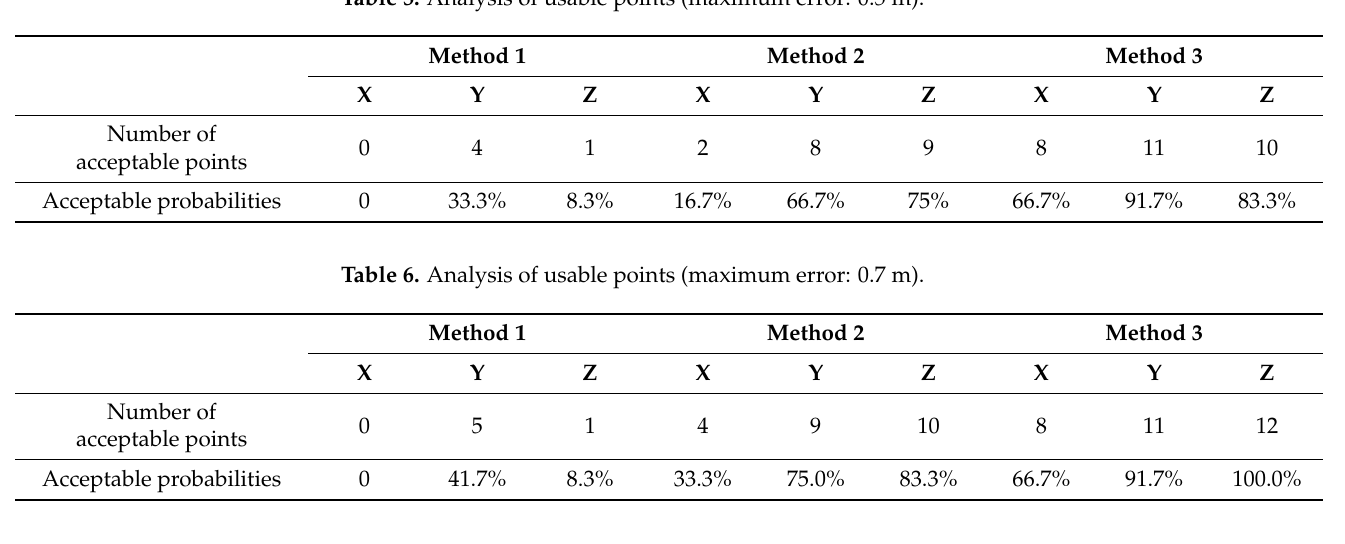
Table 5. Analysis of usable points (maximum error: 0.5 m).